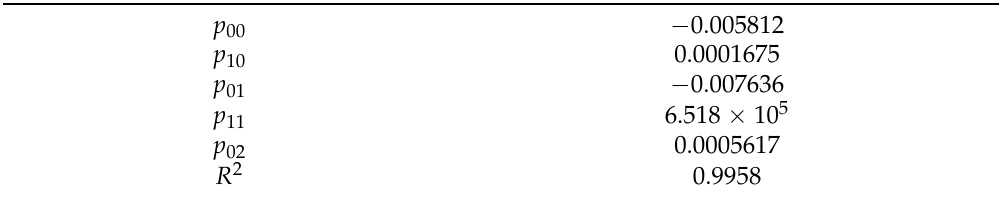
Table 2. Coefficients for fitting Equation (17), conductivity of PBI–H 3 PO 4 at different operating conditions (data from